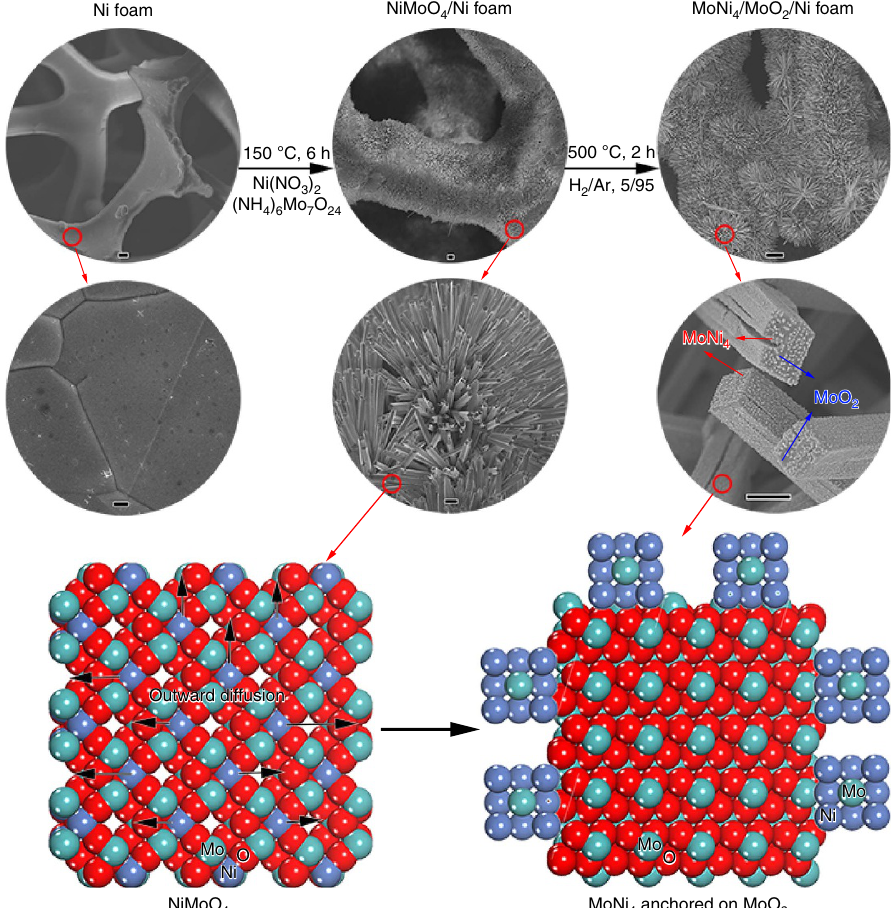
Figure 1 | Synthetic scheme of MoNi4 electrocatalyst supported by the MoO2 cuboids on nickel foam. Synthetic scheme of MoNi 4 electrocatalyst supported by the MoO 2 cuboids on nickel foam. Scale bars, Ni foam, 20 m m (top) and 1 m m (bottom); NiMoO 4 /Ni foam, 10 m m (top) and 2 m m (bottom); MoNi 4 /MoO 2 /Ni foam, 20 m m (top) and 1 m m